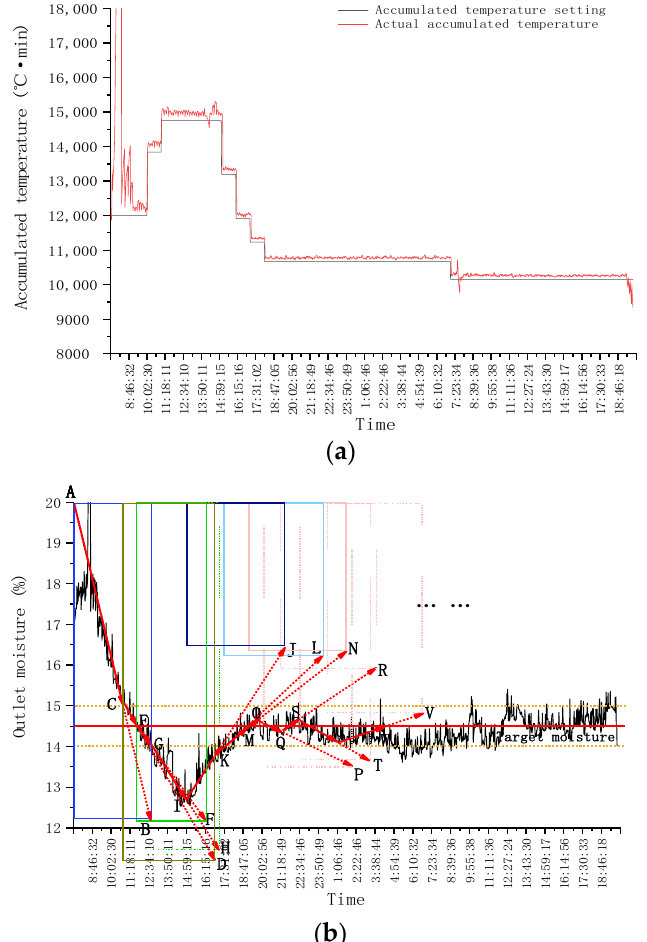
Figure 7. Variation of grain equivalent accumulated temperature and outlet moisture with time during continuous operation: ( a ) Equivalent accumulated temperature (accumulated temperature window area) change curve; ( b ) Outlet moisture change curve (moisture window area).